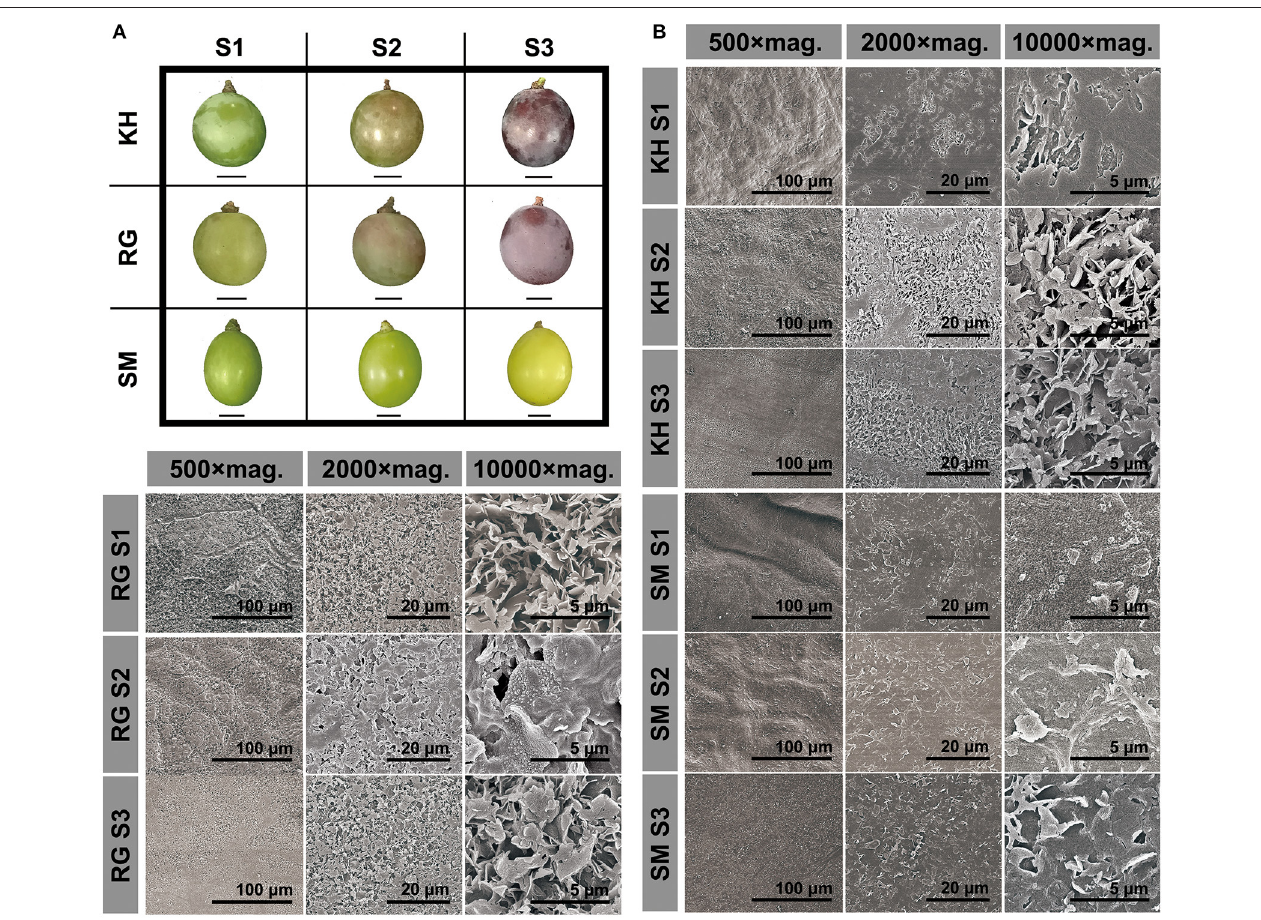
FIGURE 1 | Berry morphology (A) and microstructure of cuticular wax (B) in three grape cultivars during berry development. Three grape cultivars: KH, “Kyoho”; RG, “Red Globe”; SM, “Shine Muscat”. Three developmental stages: S1, mature-green; S2, véraison; S3, maturation. mag. Magnification. Scale bars represent the